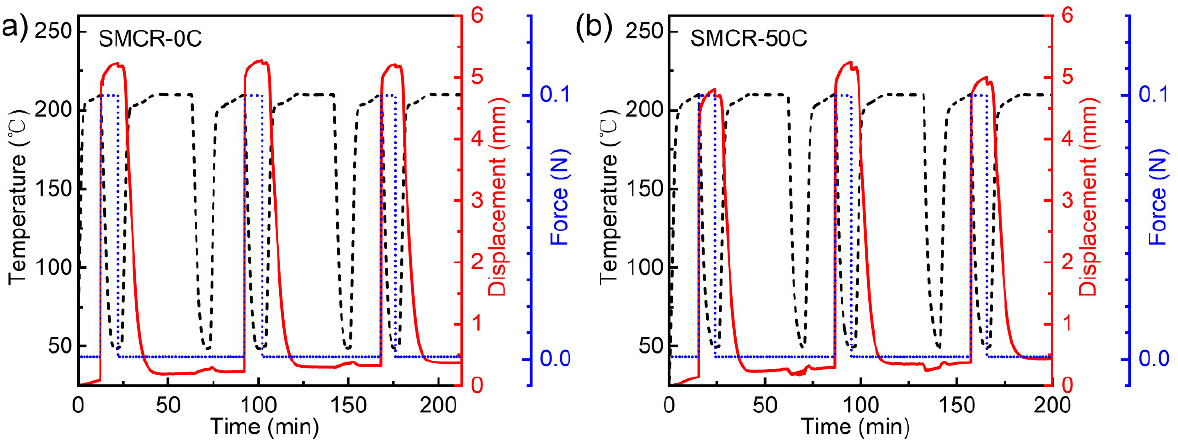
Figure 5. The e ff ect of vacuum thermal cycling on shape memory e ff ect: ( a ) SMCR-0C, ( b ) SMCR- Figure 5. The effect of vacuum thermal cycling on shape memory effect: ( a ) SMCR-0C, ( b ) 50C.